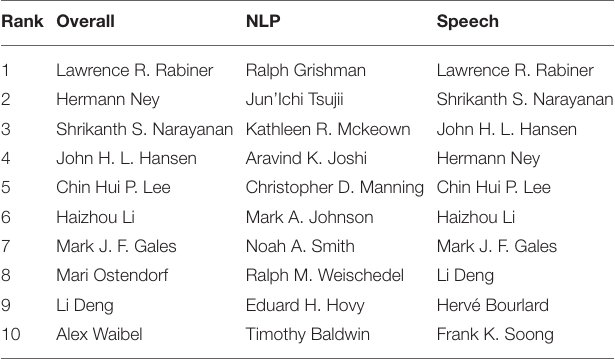
TABLE 28 | Global ranking of the sources overall and separately for Speech and NLP up to 2020. Rank Overall NLP Speech acl